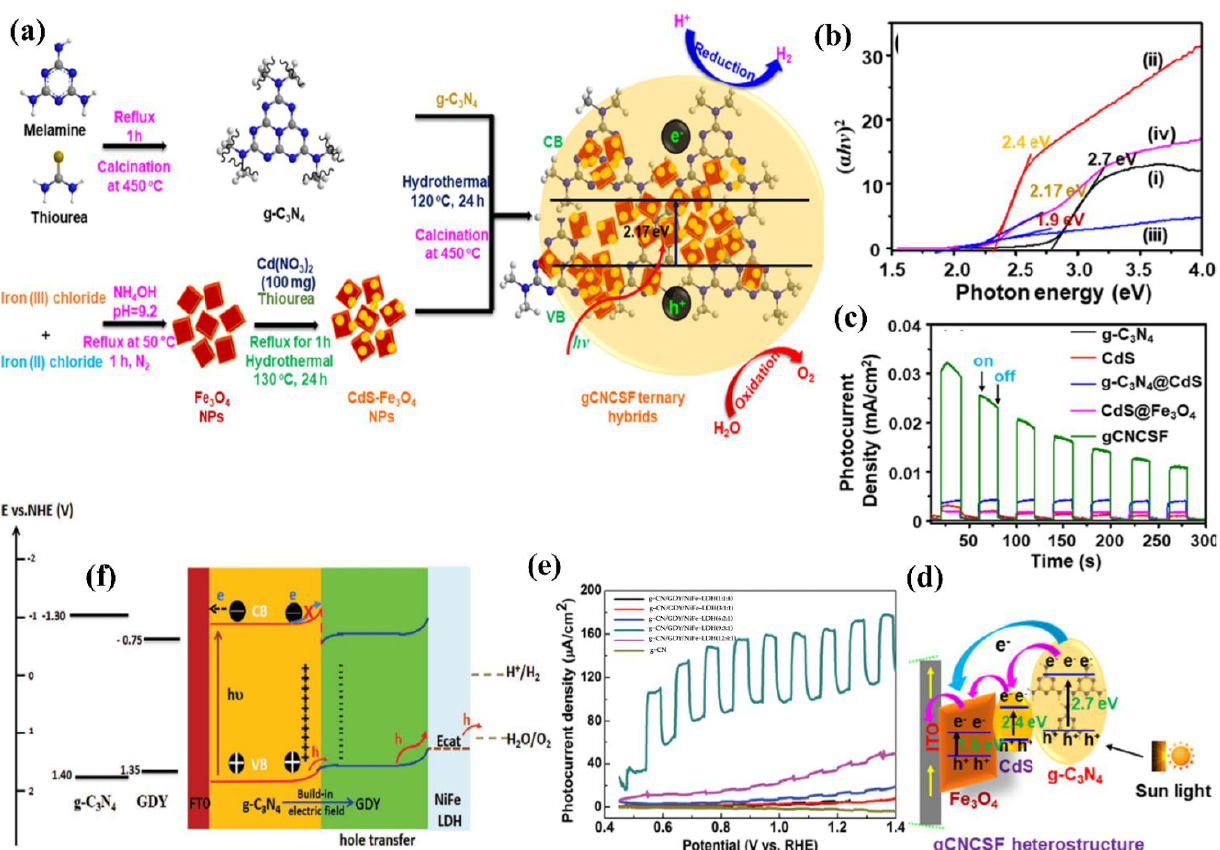
Figure 27. ( a ) Schematic diagram for the synthesis of g − CN@CdS–Fe 3 O 4 . ( b ) The Tauc plots. ( c ) Photocurrent response in 0.5M Na 2 SO 4 . ( d ) Schematic diagram of working mechanism at